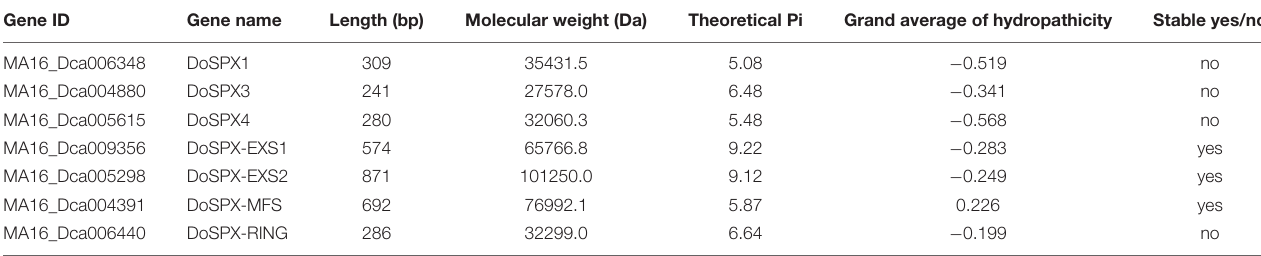
TABLE 1 | Analysis of amino acid sequence encoded by